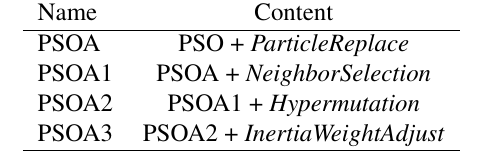
Table 4. Relation between the four different PSOA versions.